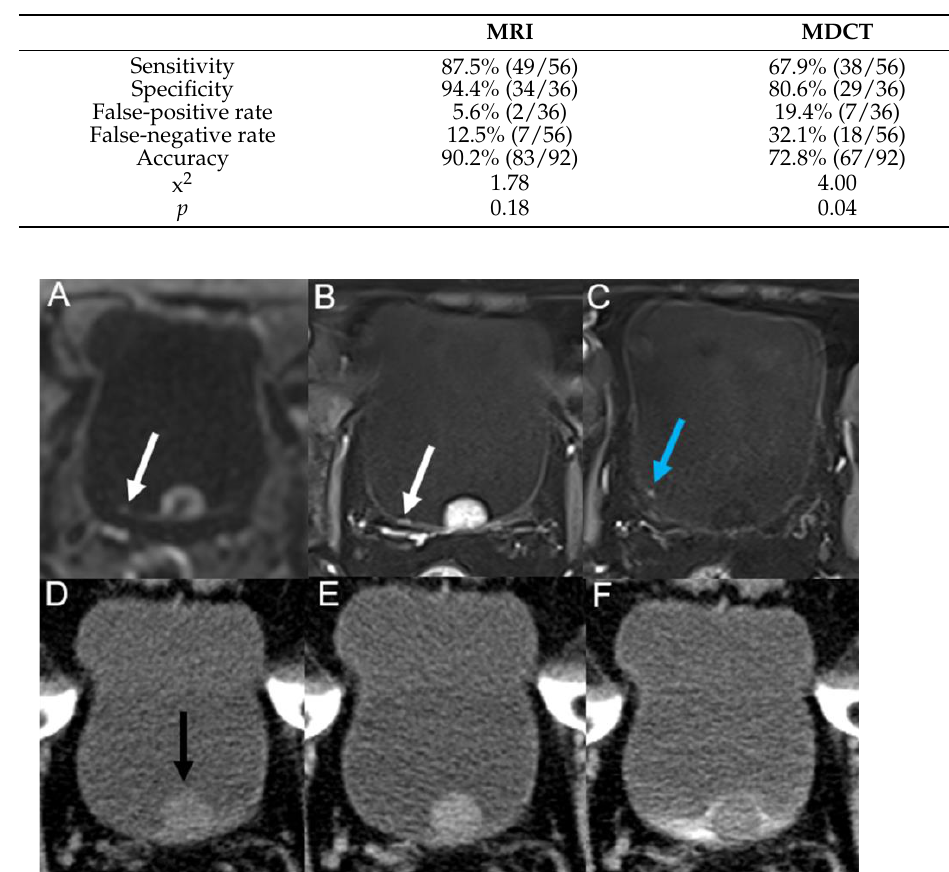
Figure 3. A 71-year-old man underwent trans-urethral resection of BC 42 months ago. MRI ( A – C ) and MDCT ( D – F ) show a papillary mass (black arrow) in median posterior wall of the bladder. A micro-nodule (white arrow) in the right posterior wall is visible on DWI ( A ) and DCE ( B ) images. Another tiny polypoid lesion (blue arrow) in the right posterolateral wall is visible on another layer of DCE-MRI ( C ). None of the two small lesions is visible on unenhanced ( D ), nephrographic ( E ), excretory ( F ) phases of MDCT. Postoperative pathology of all the lesions were non-muscle-invasive low-grade papillary urothelial carcinoma.